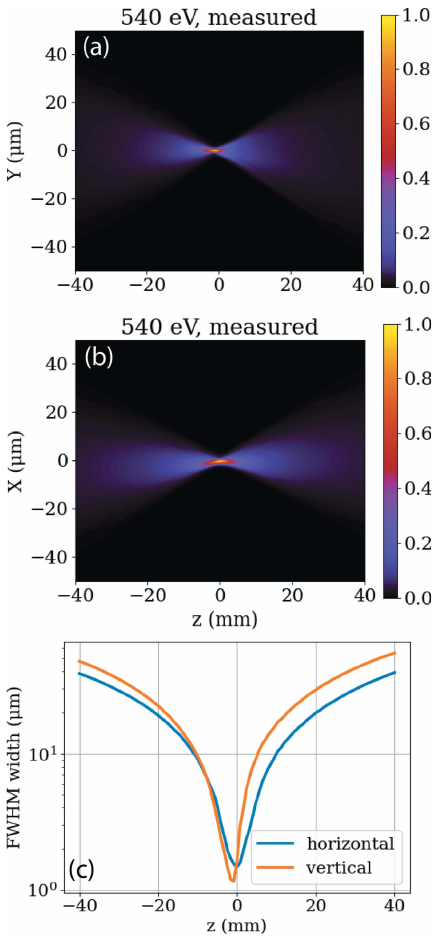
Figure 8 First wavefront measurements at the IP1 focus spot of TMO. Shown are the horizontal measured line-outs along the beam ( a ), the vertical measured line-outs along the beam ( b ), as well as the FWHM for both ( c